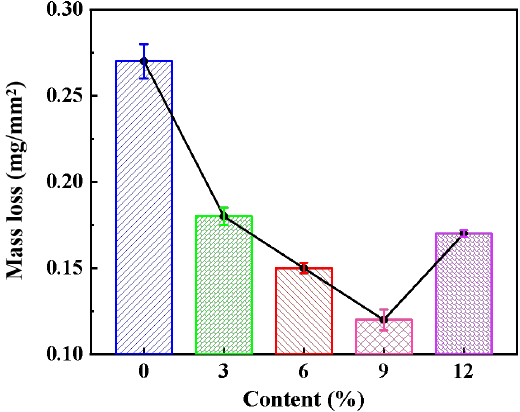
Figure 12. Mass loss curve of coating in a 3.5 wt.% NaCl solution.